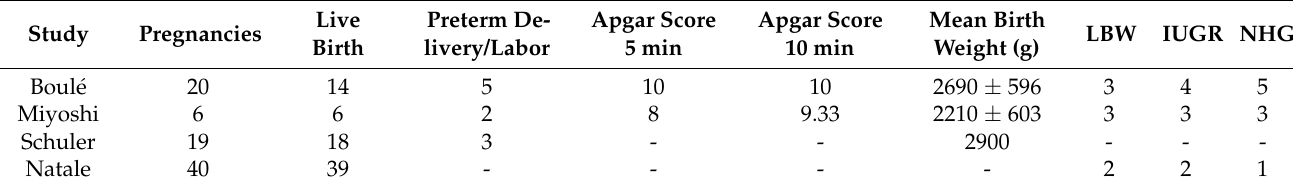
Table 7. The number of live births, preterm delivery/labor, the Apgar score at 5 and 10 min, the mean birth weight in grams, the number of fetuses with lower birth weight (LBW), intrauterine growth retardation (IUGR) and neonatal hypoglycemia